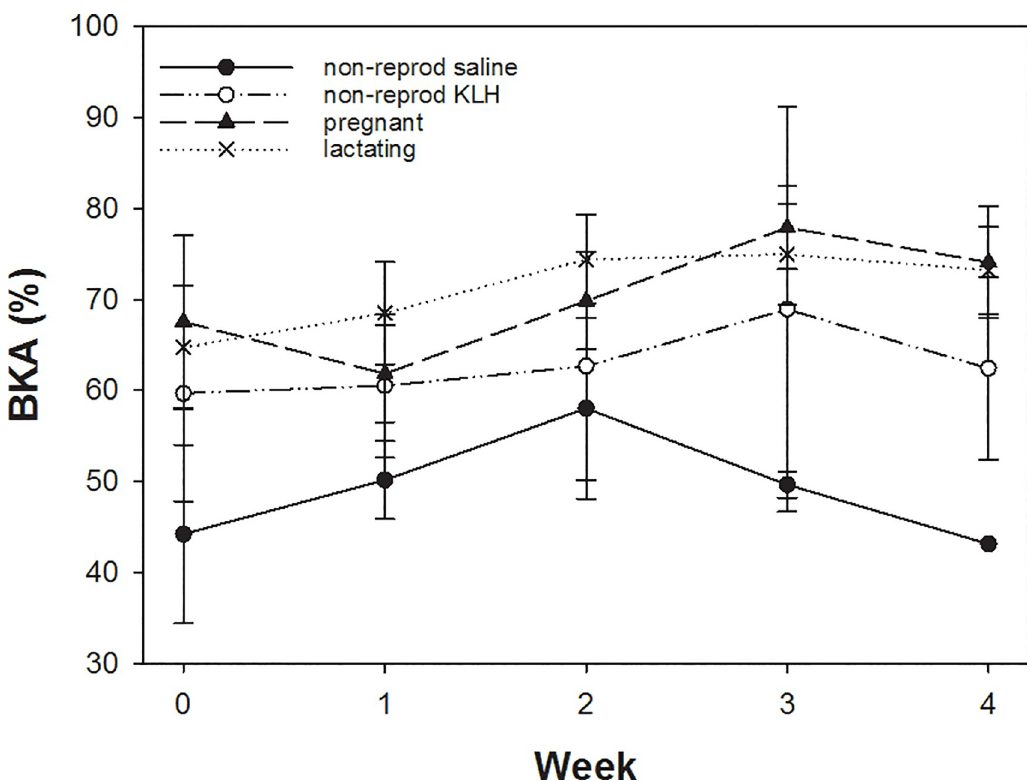
Fig 3. Differences in BKA across the 4 weeks for control, non-reproducing, pregnant and lactating females. Plotted are means and SE. For details see text.